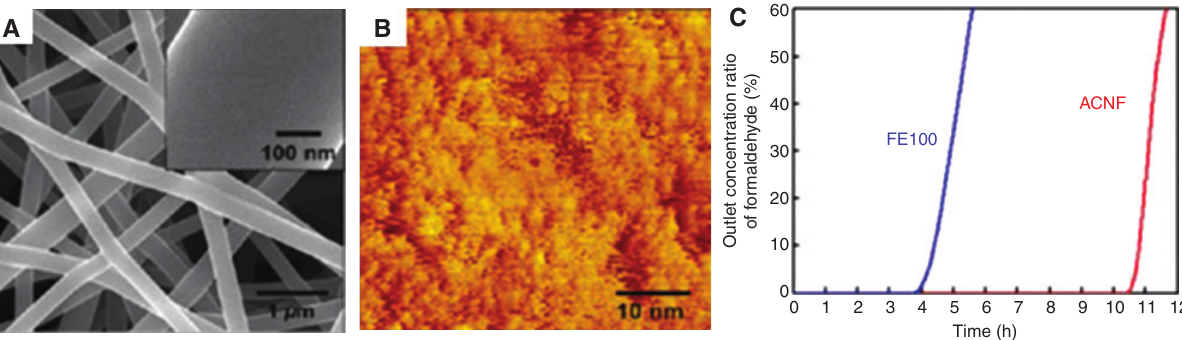
Figure 5: (A) SEM image and (B) STM image of PAN nanofiber carbonized at 600 ° C for 1 h under He atmosphere. (C) Breakthrough curves of formaldehyde (11 ppm) in dry condition for FE100 (conventional ACF) and PAN-based ACNF (activation conditions: 600 ° C, RH 90%, 1 h). For details, see Ref. [30]; reprinted with permission from